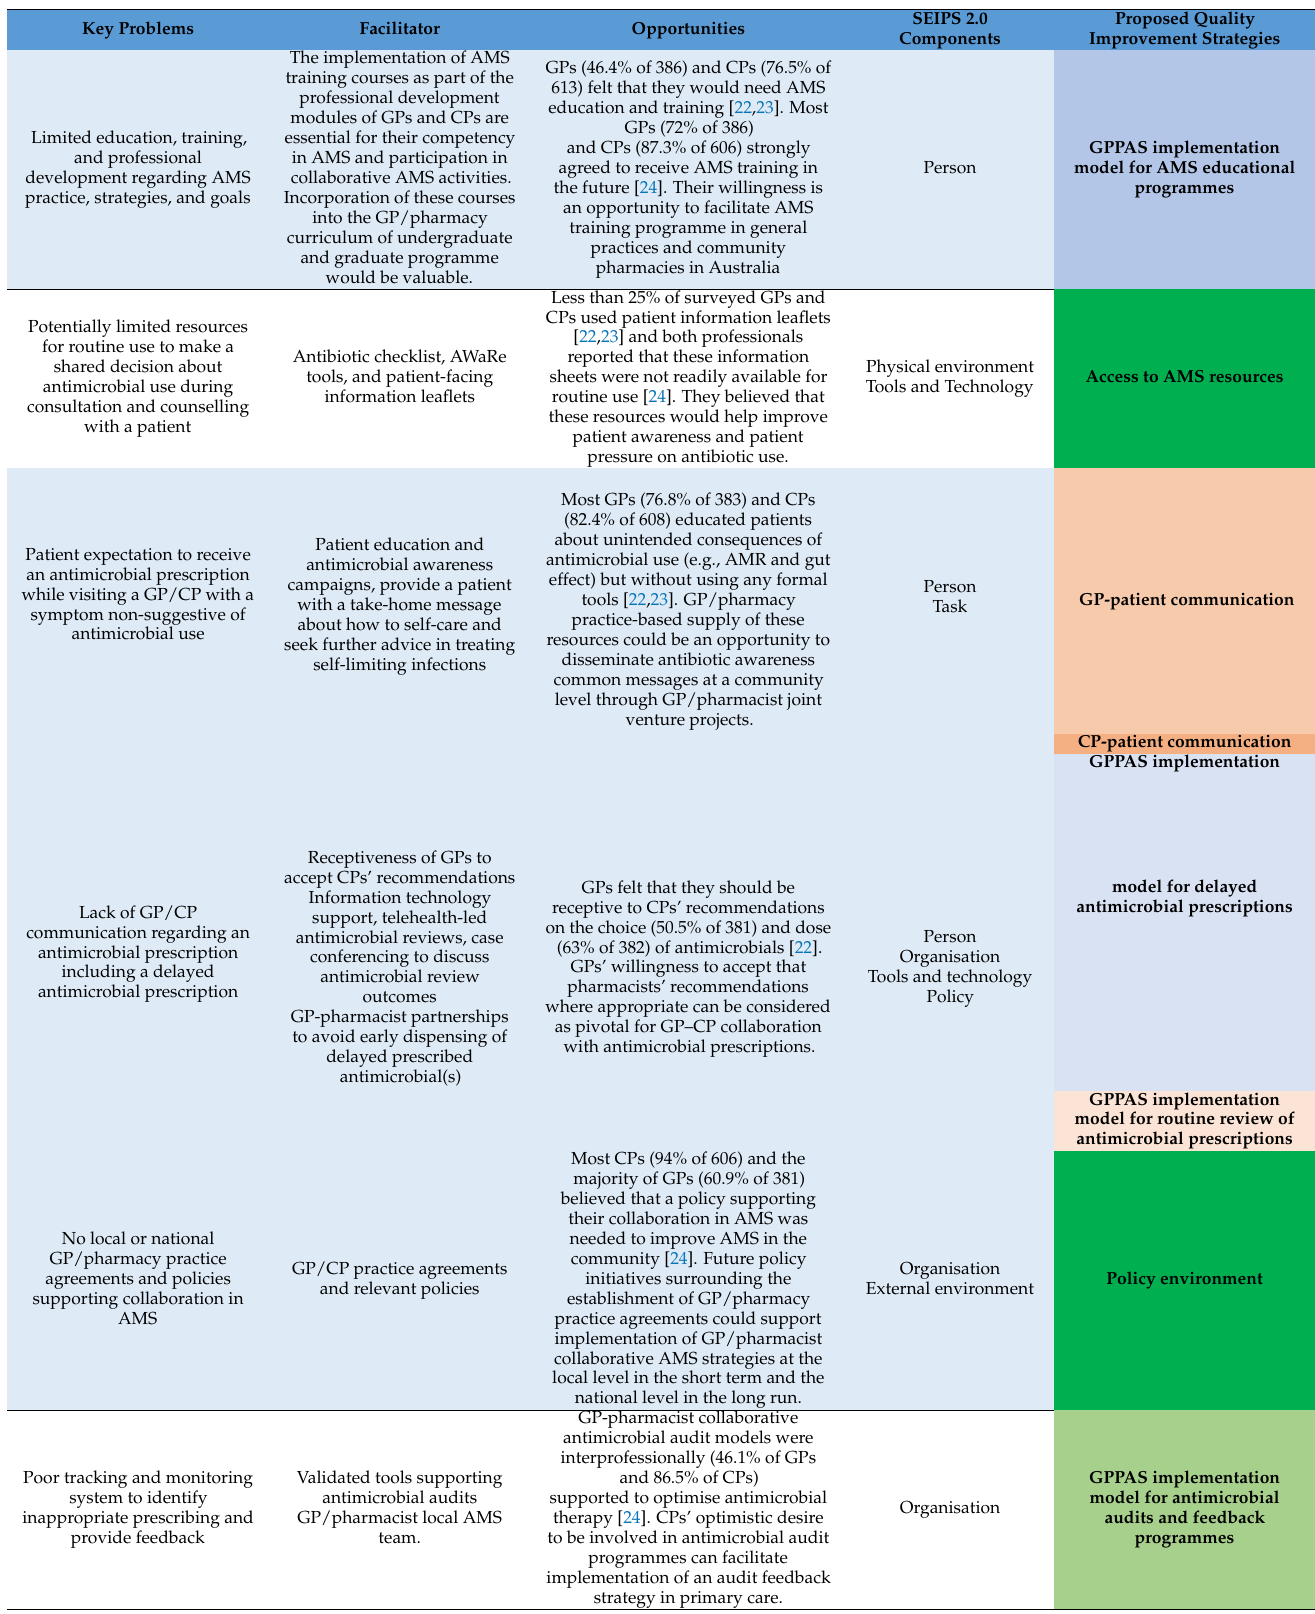
Table 2. Key problems, facilitators, opportunities, and quality improvement strategies to routinely implement AMS activities through collaboration between GPs and